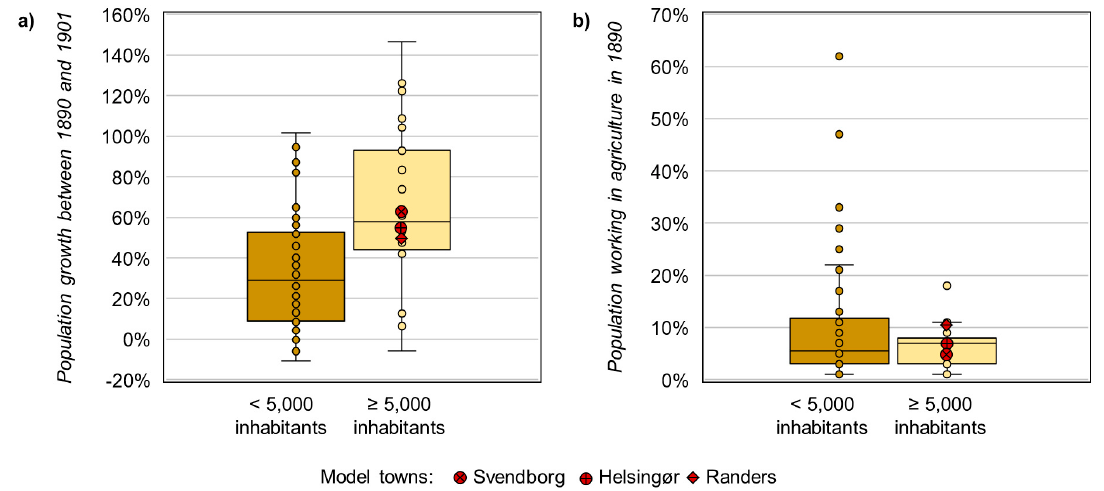
Figure 2. Box plots showing ( a ) the population growth between 1880 and 1901 [8]; ( b ) the fraction of agricultural workers in 1890 [38]; in 25 towns ( > 5000 inhabitants) and 55 smaller settlements ( < 5000 inhabitants). The points represent the values for single towns, with red points representing model towns. The boxes show the 25% and 75% quantiles and points outside of the whiskers and are considered outliers. The vertical lines within the boxes show the median.